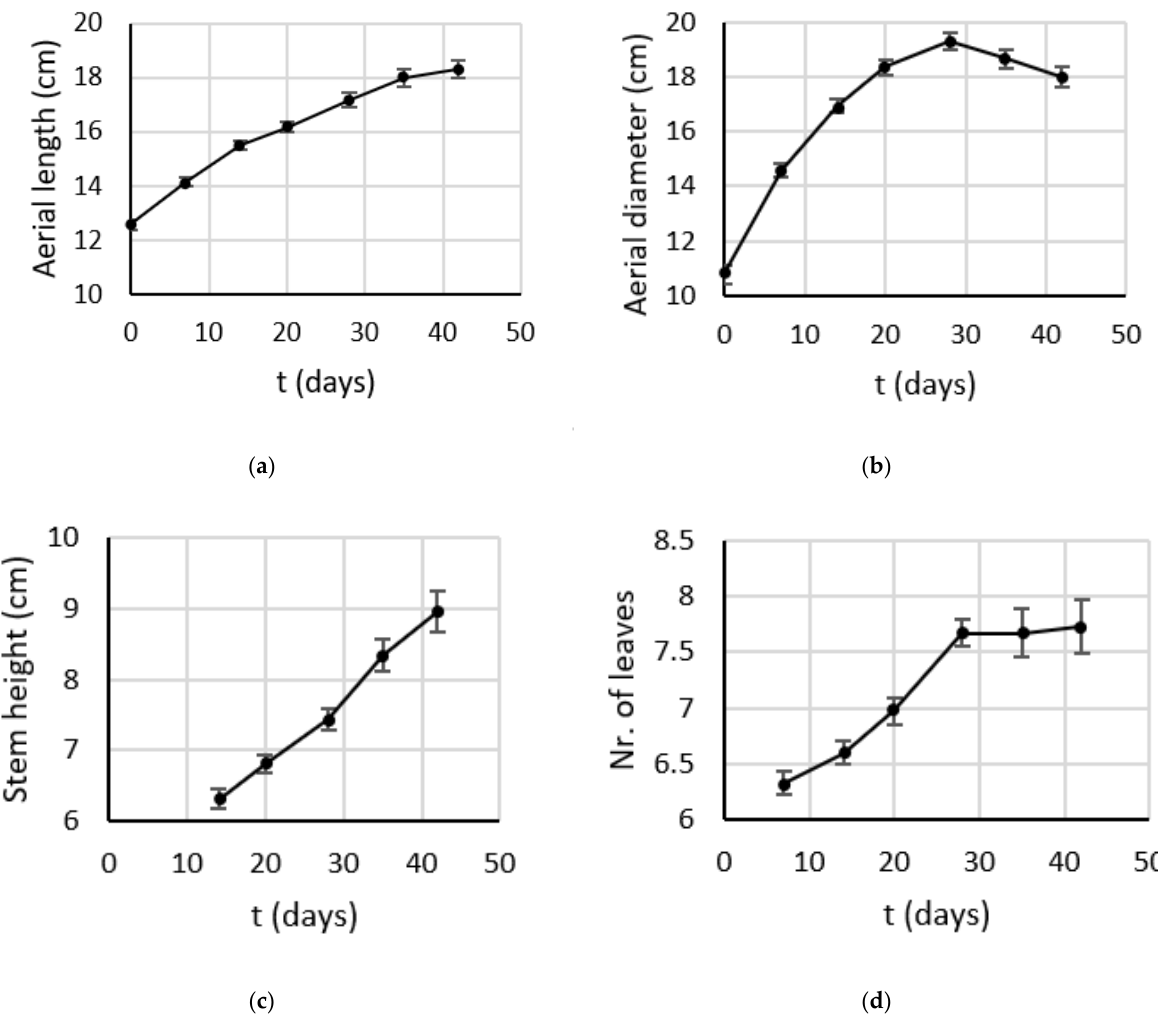
Figure 4. Growth of hydroponically cultivated crops: ( a ) aerial parts length; ( b ) aerial parts spread; ( c ) stem height; ( d ) number of leaves.